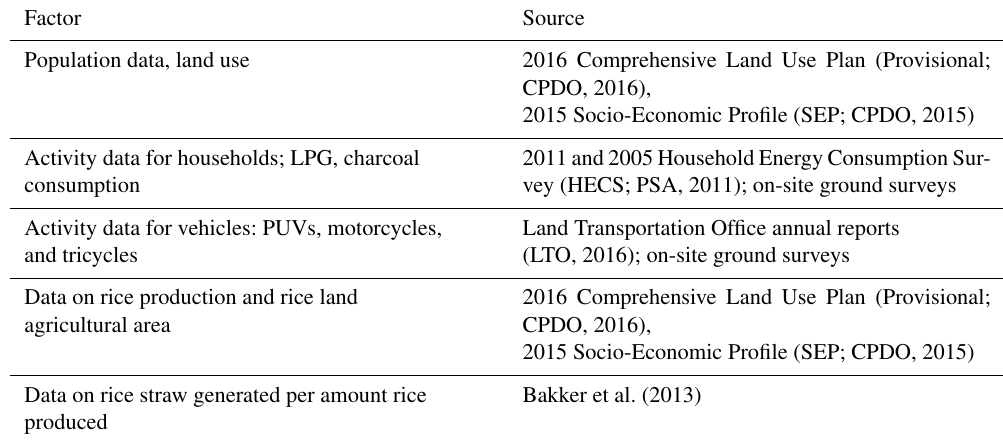
Table 2. Data sources for activity